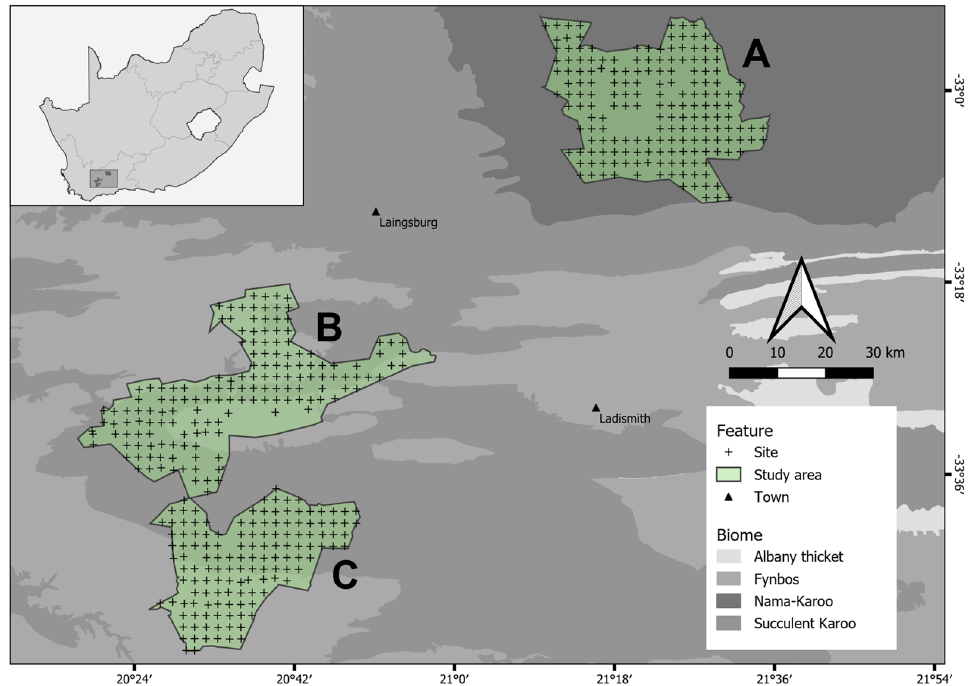
Figure 1. The location of the three land-uses (farmland [ A ], statutory PA [ B ] and private PA [ C ]) within the Karoo and the major biomes in the region. Black and green polygons represent the cadastral boundaries of each land-use, and (+) shows the position of the camera traps (i.e., sites) within them. Camera traps were spaced approximately 2km apart. Areas within the farmland with no camera traps present indicate landowners unwilling to permit access or faulty camera traps, and gaps in the statutory and private PA represent inaccessible areas due to extreme terrain (i.e., cliffs) and faulty camera traps. Insert shows the three land-uses within South Africa.